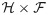
Illustration of the causality Shannon-Fisher plane plane (H×F) as data-analytical tool.
H×F is used to classify relevant processes, such as constant/periodic signals, white and coloured noise (noise with a power spectrum proportional to 1/fk), and deterministic signals (e.g. chaotic maps), similar to Fig 1. For all calculations, D = 6, τ = 1, and n = 104 were chosen.